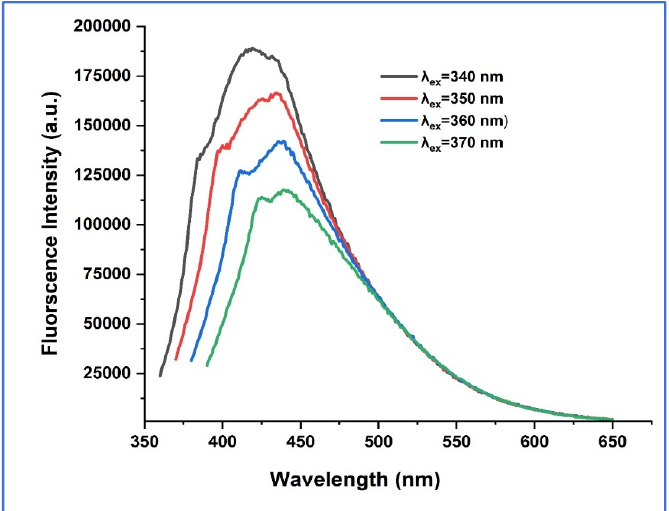
Figure 3. Fluorescent emission spectra of CDs at different excitation wavelengths in the 340–370 nm Figure 3. range.